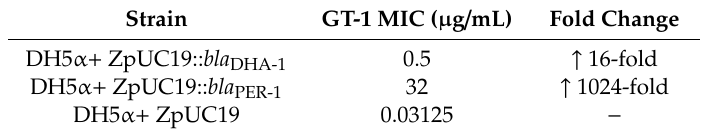
Table 3. Minimum inhibitory concentrations (MICs) of transformed E. coli DH5 α